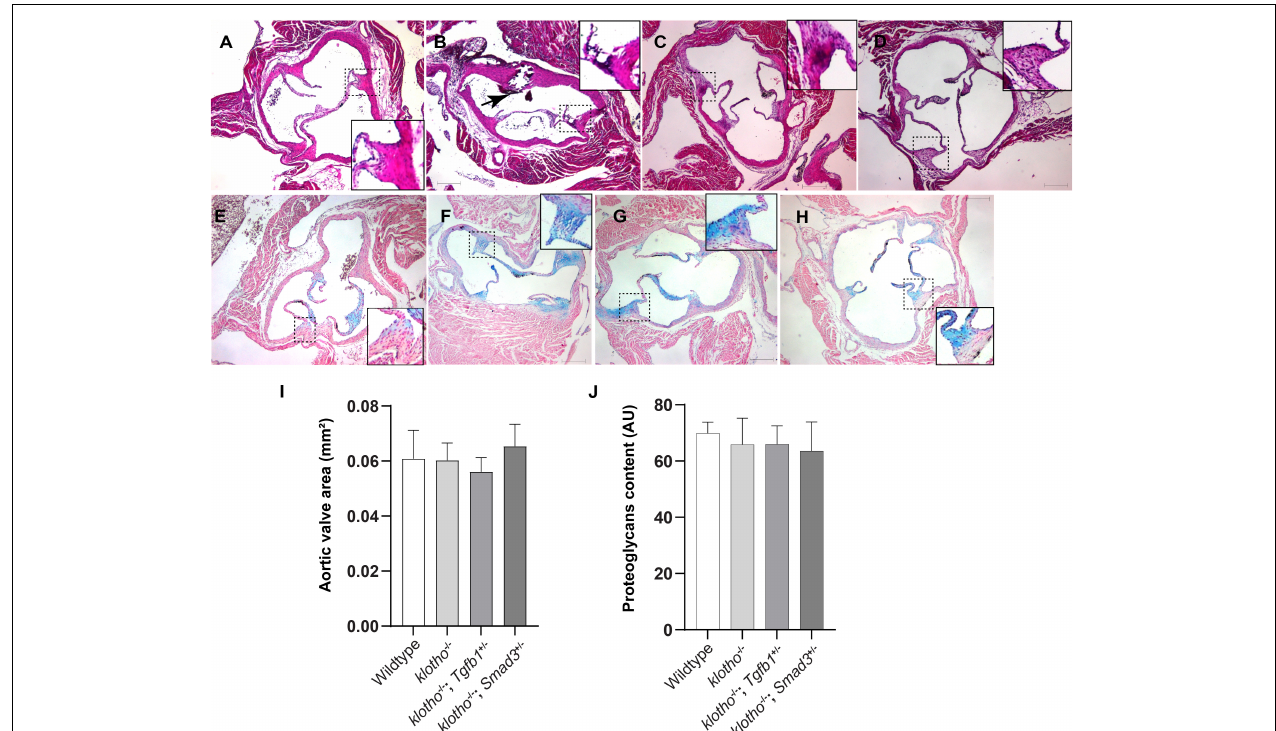
FIGURE 2 | Effect of lowering of TGF β 1 and SMAD3 on AV structure and proteoglycan (GAG) distribution in 10- to 12-week-old Kl − / − mice. (A–D) Hematoxylin and eosin (H&E) staining and (E–H) Alcian blue staining of wild-type, Kl − / − , Kl − / − ;Tgfb1 ± , and Kl − / − ;Smad3 ± mice showing aortic valve histology and proteoglycans distribution. A magnified view showing further details of the boxed region is presented for each image. (I–J) Quantitative analysis of AV area in H&E-stained (I) and proteoglycans content in alcian blue-stained (J) images. Quantification of AV area and GAG content was done on multiple serial sections from each animal per group by using NIH- Image J software. Values indicate mean ± SD ( n = 5). Scale bars = (A–H) 200 µ m.